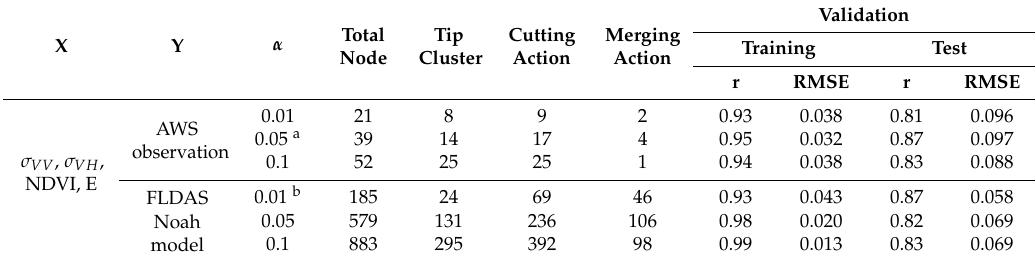
Table 2. The statistics of SCA cluster trees at different significance level.